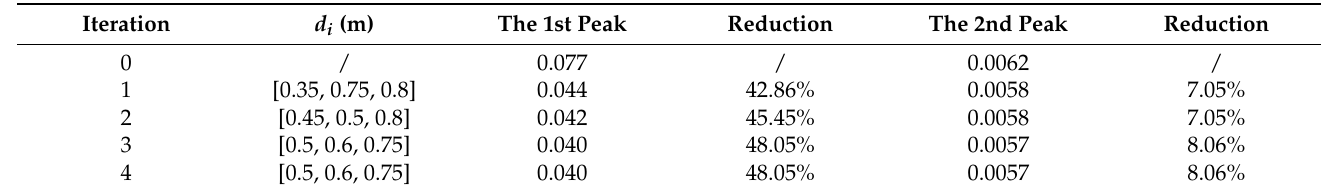
Table 2. The distribution optimization process of the genetic algorithm.